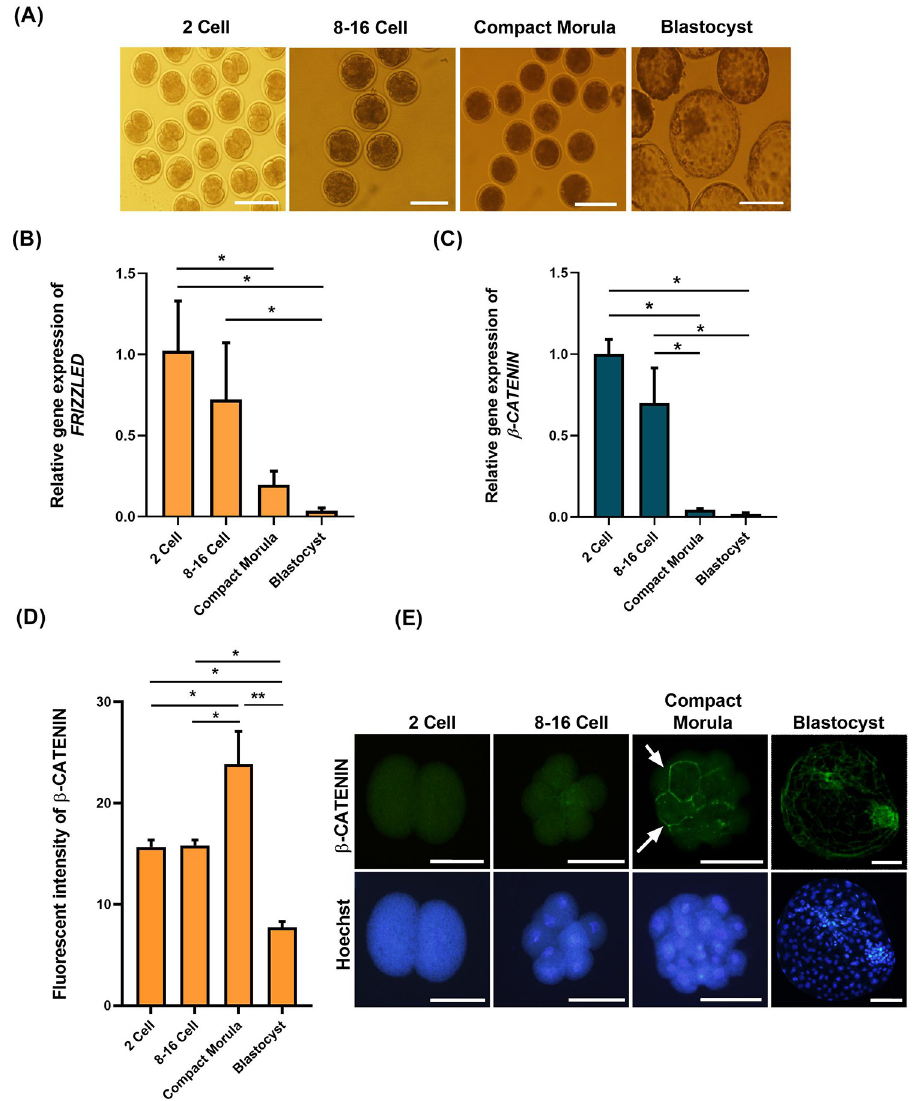
Fig 1. (A) The representative bright-field images of preimplantation development of IVF embryos including (from left to right) 2-cell, 8–16 cell, compact morula and blastocyst stages in goat. A relative pattern of mRNA expression for (B) FRIZZLED and (C) β -CATENIN during preimplantation embryo development of IVF embryos at the indicated developmental stages. (D) Quantification of the fluorescent intensity of β -CATENIN level in IVF embryos at the indicated developmental stages. (E) Representative immunofluorescence images of β -CATENIN in IVF embryos at the indicated developmental stages. Mean ± S.E.M. (standard error of the mean) values are from at least three independent experiments ( * P < 0.05 and ** P < 0.01). Scale bars represent 100 μ